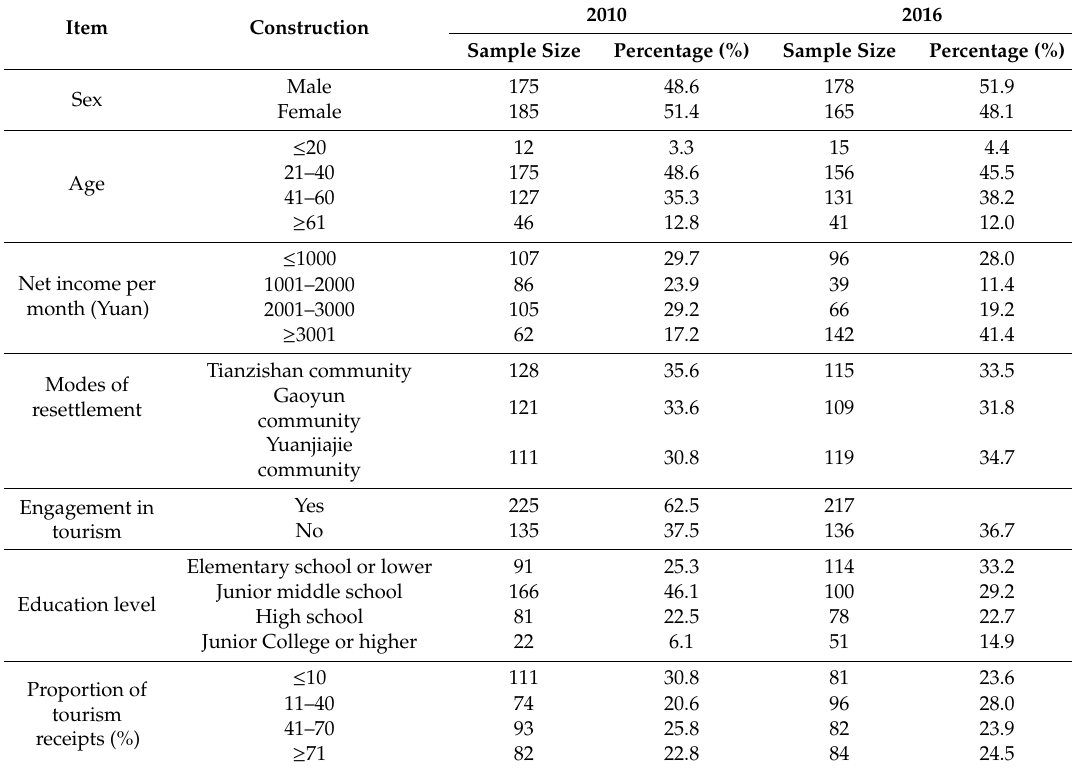
Table 1. Social demographic characteristics of the respondents in 2010 and